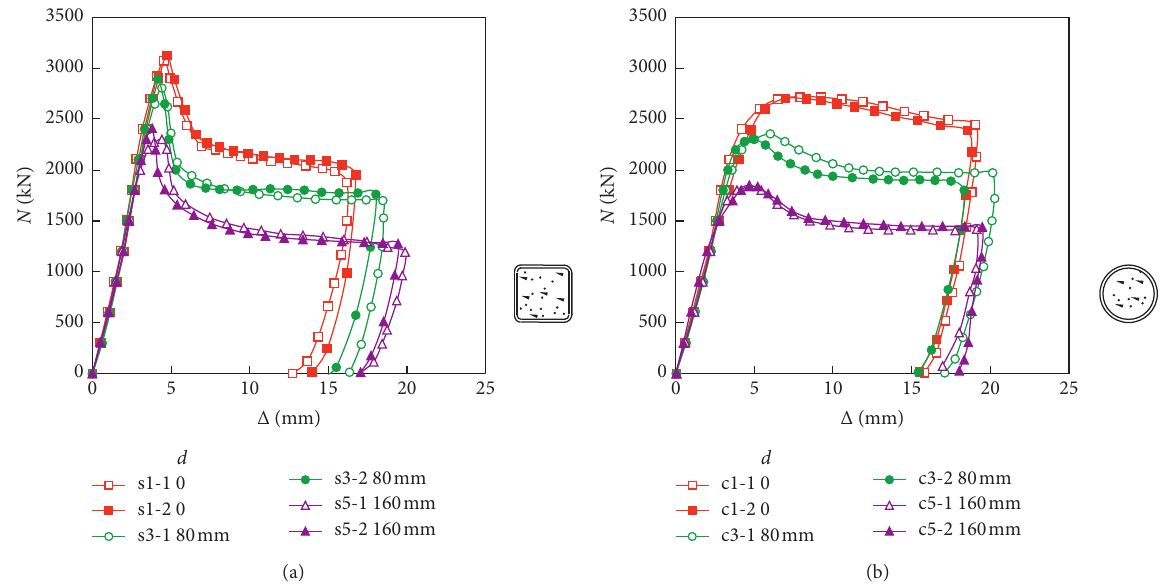
Figure 7: Effects of holes size on load (N) versus deformation ( Δ ) diagrams. (a) Square section. (b) Circular section.